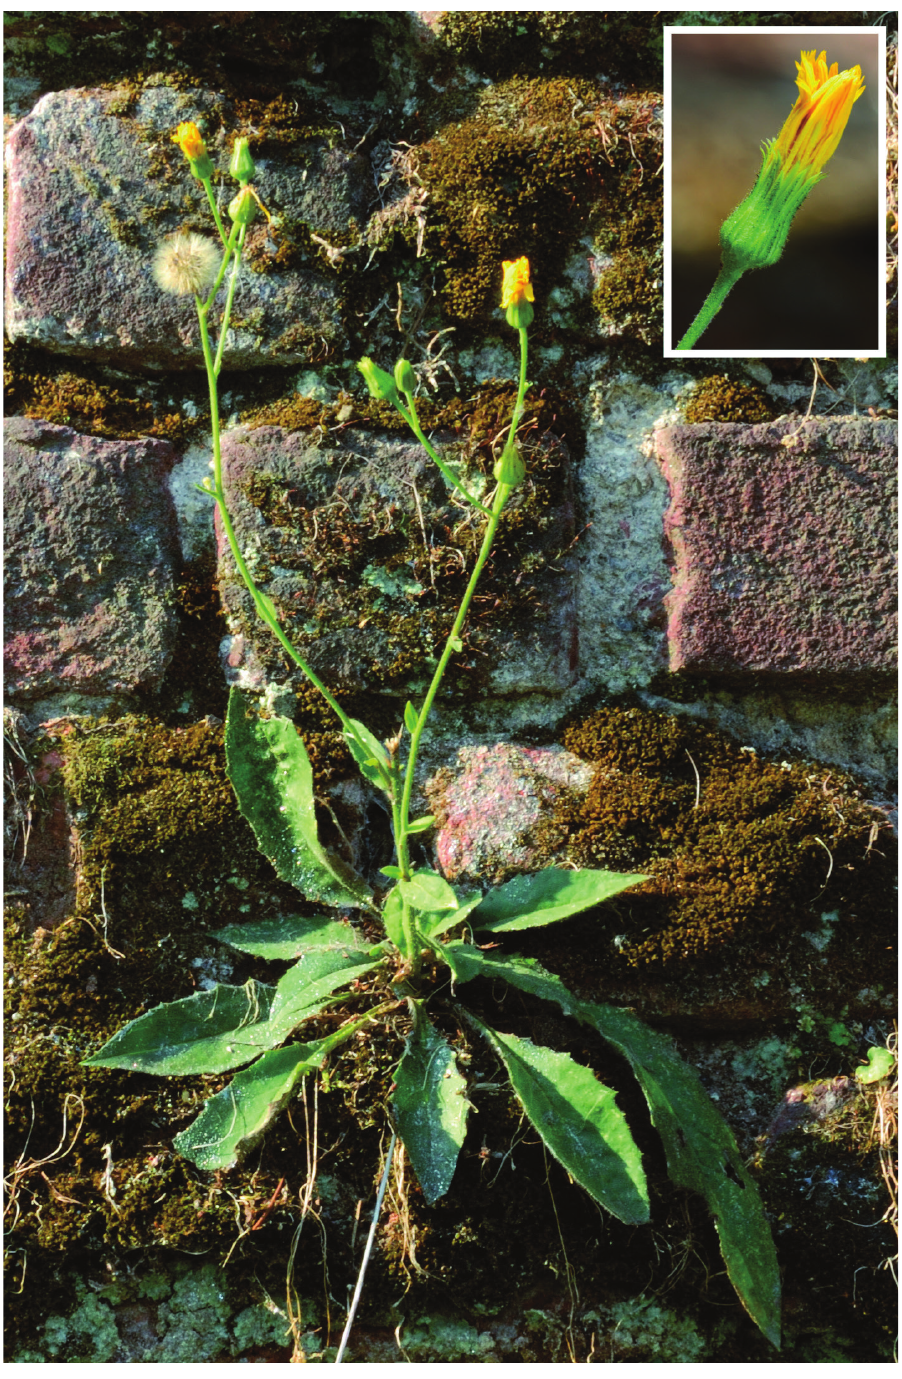
Figure 5. Hieracium australe subsp. australe photographed in Sforza Castle (Milano). Photograph by G.